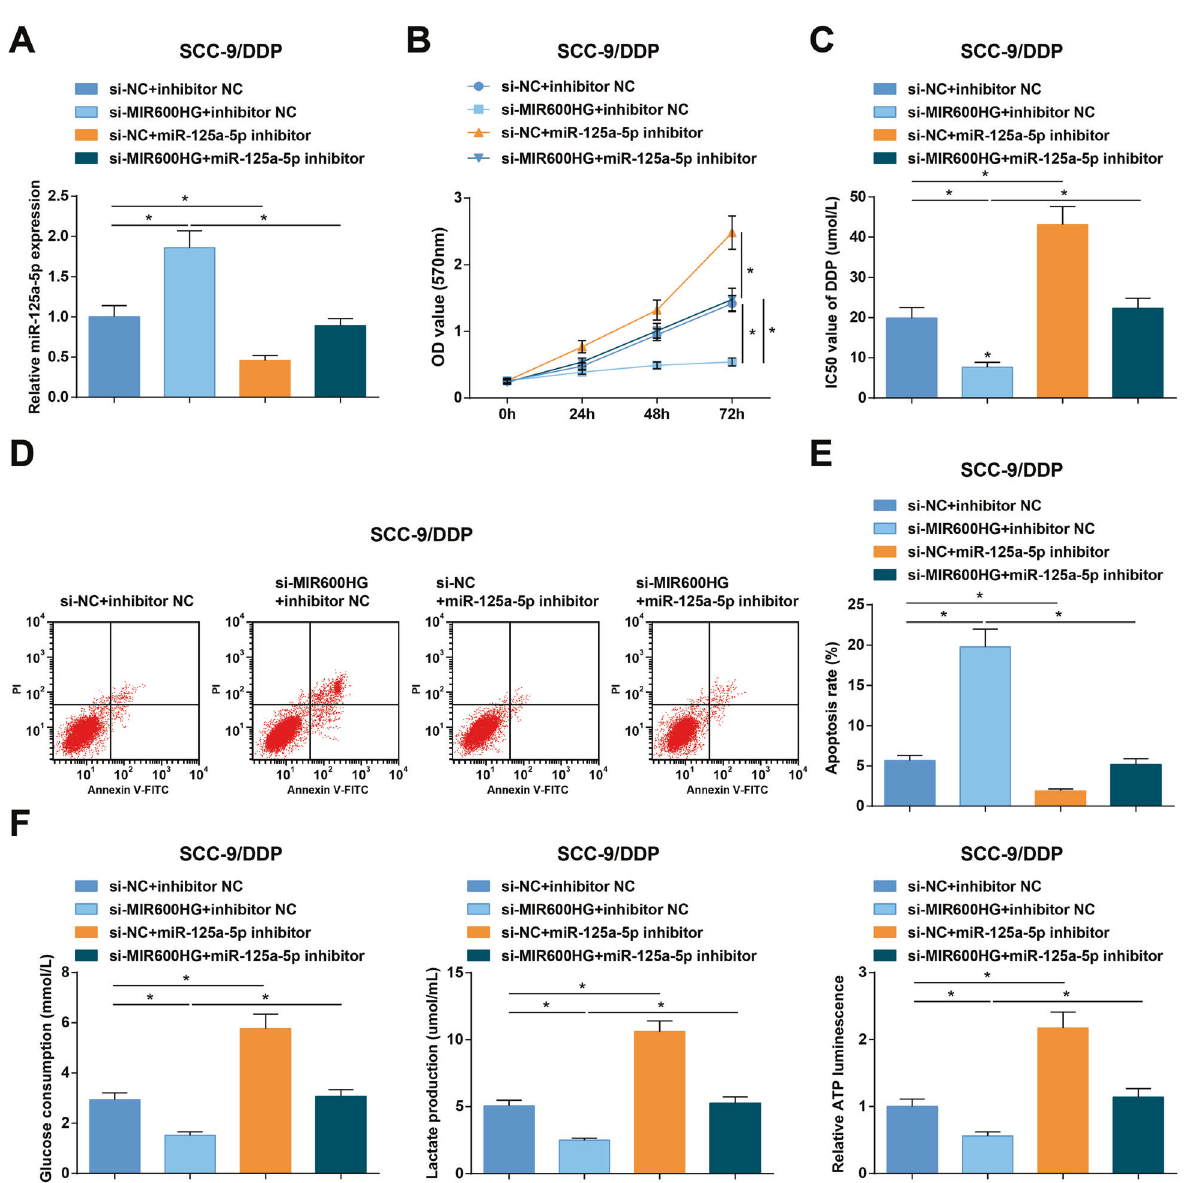
Fig. 4 miR-125a-5p inhibition reverses the role of MIR600HG silencing on DDP-resistant OSCC cells. A miR-215a-5p expression in SCC-9/ DDP cells after transfection of si-MIR600HG + miR-125a-5p inhibitor or si-MIR600HG + inhibitor NC was assessed using RT-qPCR; B viability of SCC-9/DDP cells was determined using MTT assay; C IC 50 of SCC-9/DDP cells was determined using MTT assay; D , E apoptosis of SCC-9/DDP cells was detected using fl ow cytometry; F glycometabolism of SCC-9/DDP cells was analyzed; N = 3; * P < 0.05; data were expressed as mean ± standard deviation; and ANOVA was used to analyze